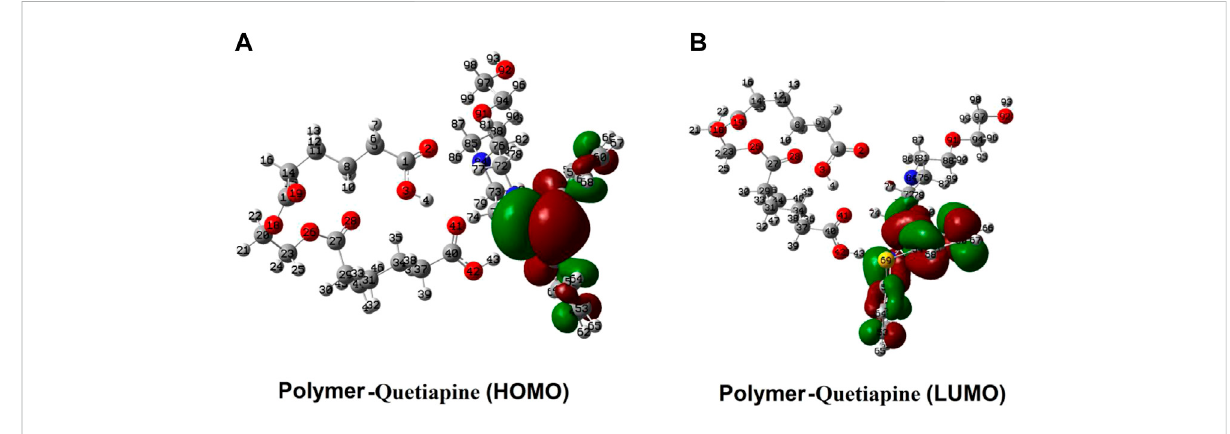
FIGURE 9 Spatial distribution of the FMOs of quetiapine (the guest) and the polymer matrix (the